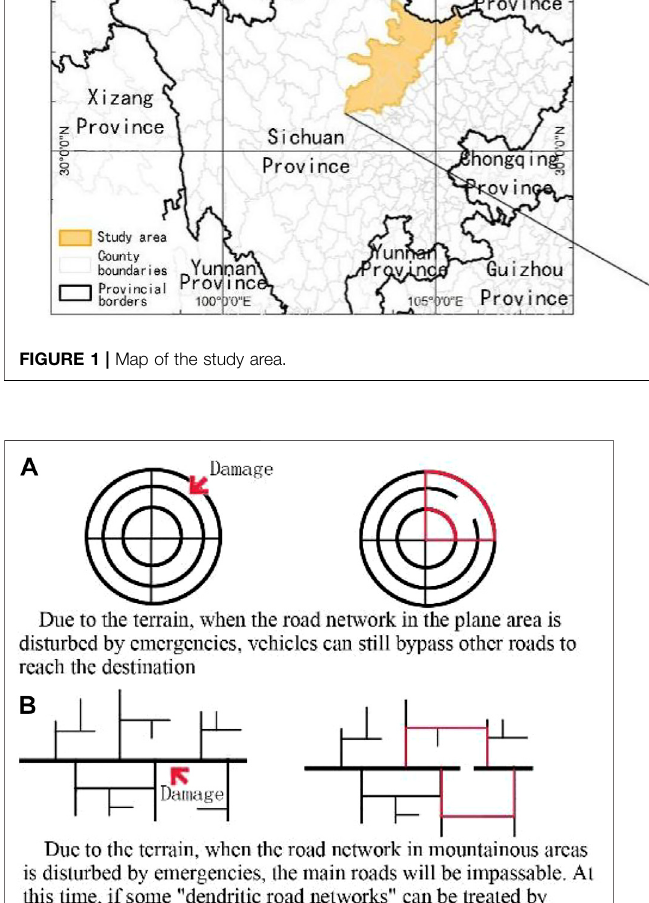
FIGURE 2 | Evolution of characteristics of highway networks in plains and mountainous